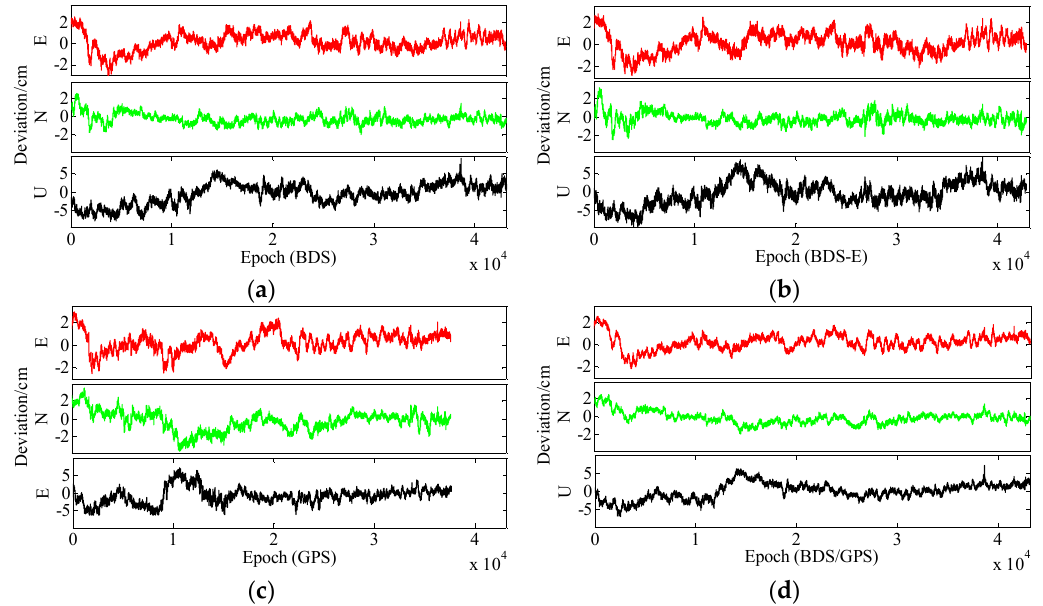
Figure 14. ENU deviations of four systems for group B. ( a ) ENU deviations of BDS for group B. ( b ) ENU deviations of BDS-E for group B. ( c ) ENU deviations of GPS for group B. ( d ) ENU deviations of BDS/GPS for group B.